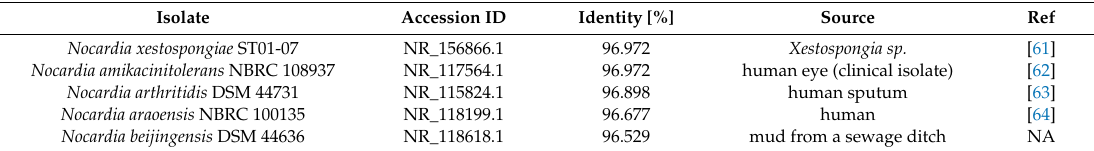
Table 3. List of validly published strains of genus Nocardia. Identity calculated against strain Nocardia sp.